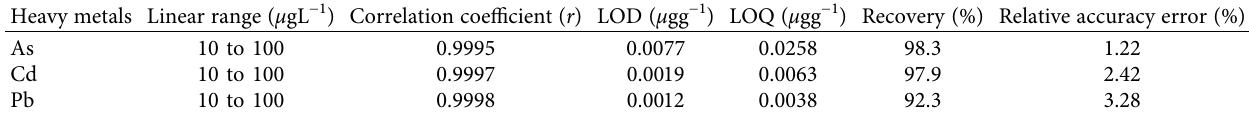
Table 2: Linear range, correlation coefficient, and limits of detection (LOD) and limits of quantification (LOQ) values for calculating As, Cd, and Pb using